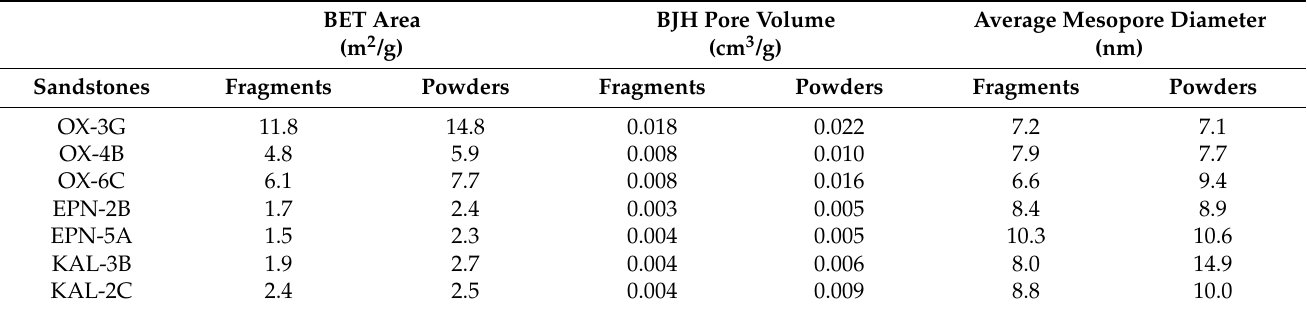
Figure 6. N 2 adsorption (solid symbols) and desorption (open symbols) isotherms recorded at − 196 ◦ C for the degassed sandstones as fragments ( a ) and fine powders ( b ). Table 5. Pore structure properties deduced by N 2 adsorption data recorded at 77